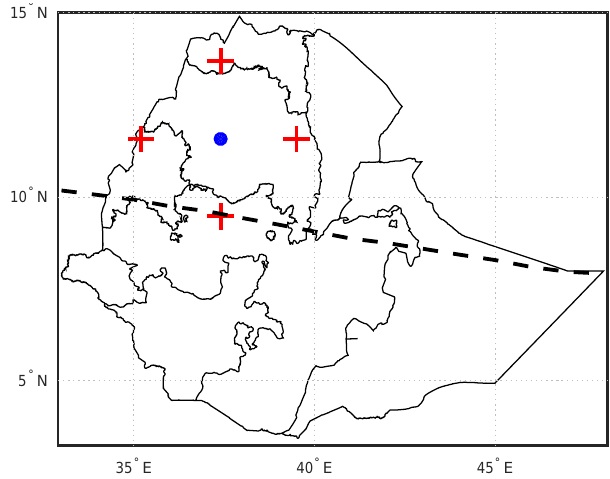
Figure 1. Map of Ethiopia showing the location of the FPI obser- vatory and the zenith look direction (blue dot). The four cardinal FPI look directions are north, south, east and west as indicated by the red crosses. Also plotted (dashed black line) is the geomagnetic